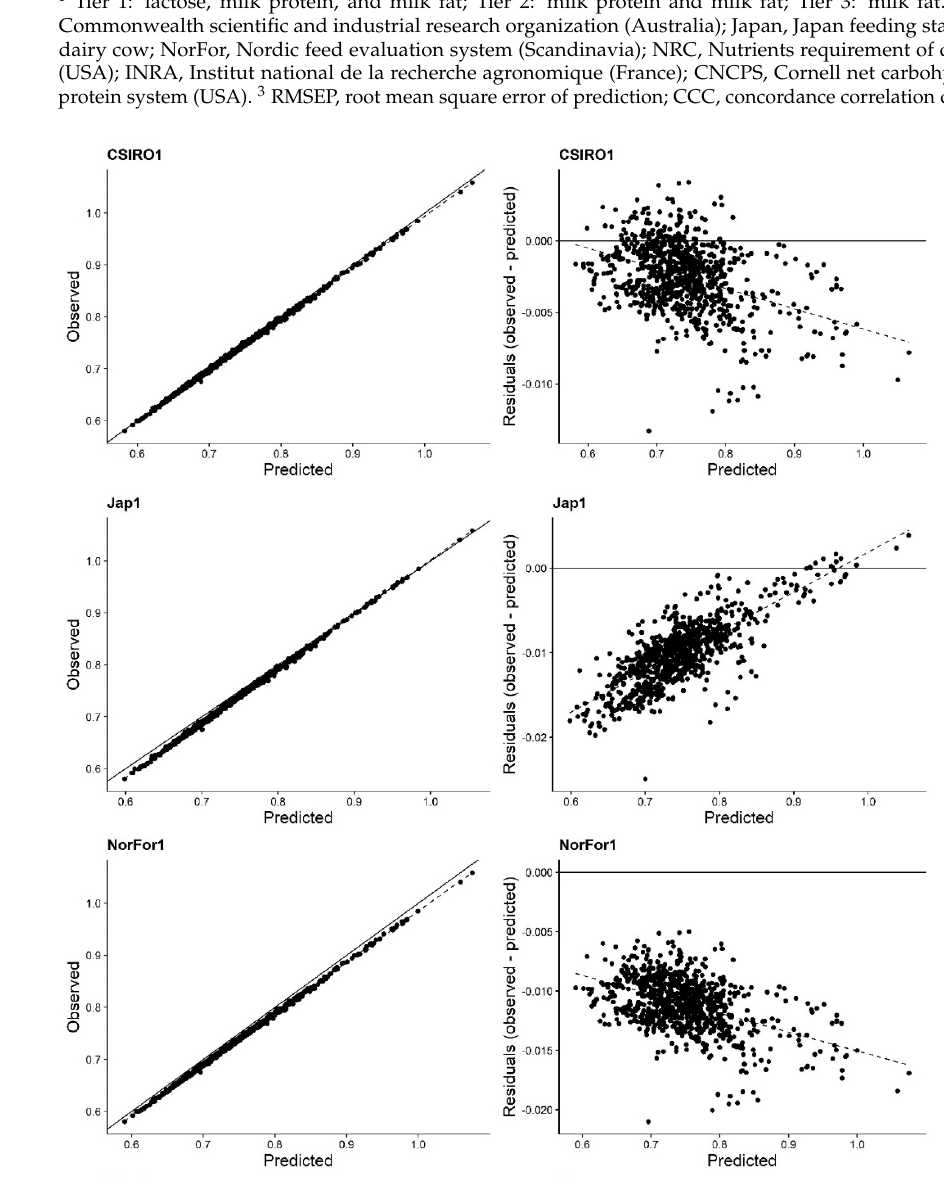
Figure 1. Plots of observed versus predicted milk energy (Mcal/L) and observed minus predicted (residual) versus predicted milk energy (Mcal/L) using Tier 1 equations. The dotted lines represent the regression lines. CSIRO, Commonwealth Scientific and Industrial Research Organization; Jap, Japan; NorFor, Nordic feed evaluation system (Scandinavia); NRC, National Research Council. Tier 2 equations, which used milk protein and milk fat as variables, were included in the NRC, NorFor, and INRA systems. All three Tier 2 equations showed high and similar predictivity, with R 2 = 0.98, RMSEP = 0.01, and CCC = 0.99. Although the mean and slope biases were significant, the bias was mostly random in the Tier 2 equations (Table 4). The Tier 2 models showed a positive residual when the predicted milk energy was low and a negative residual as the predicted value increased. The inflection point was 0.83, 0.67, and 0.68 Mcal/kg for the INRA, NorFor, and NRC equations, respectively (Figure 2).